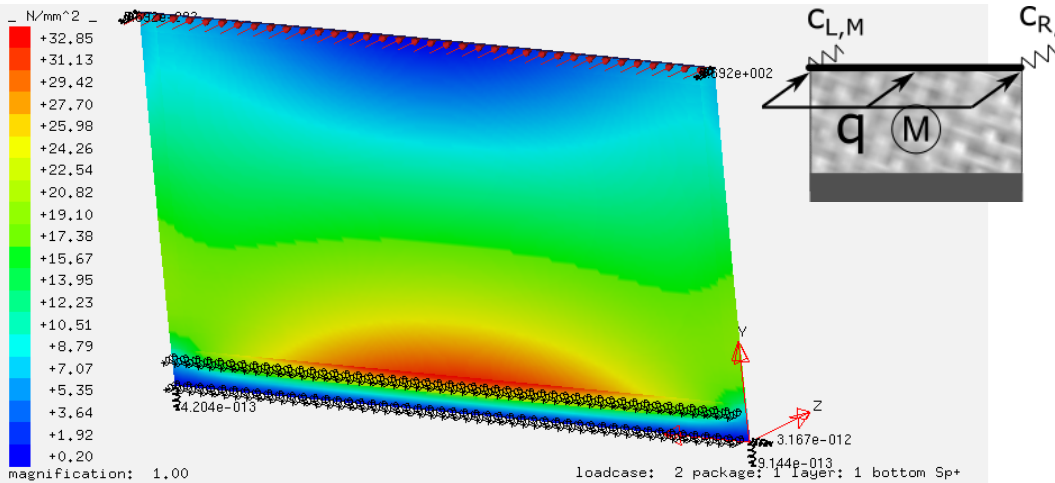
Fig. 7 Stress determination for the middle element, situation "C_C" simulated with SJ MEPLA®